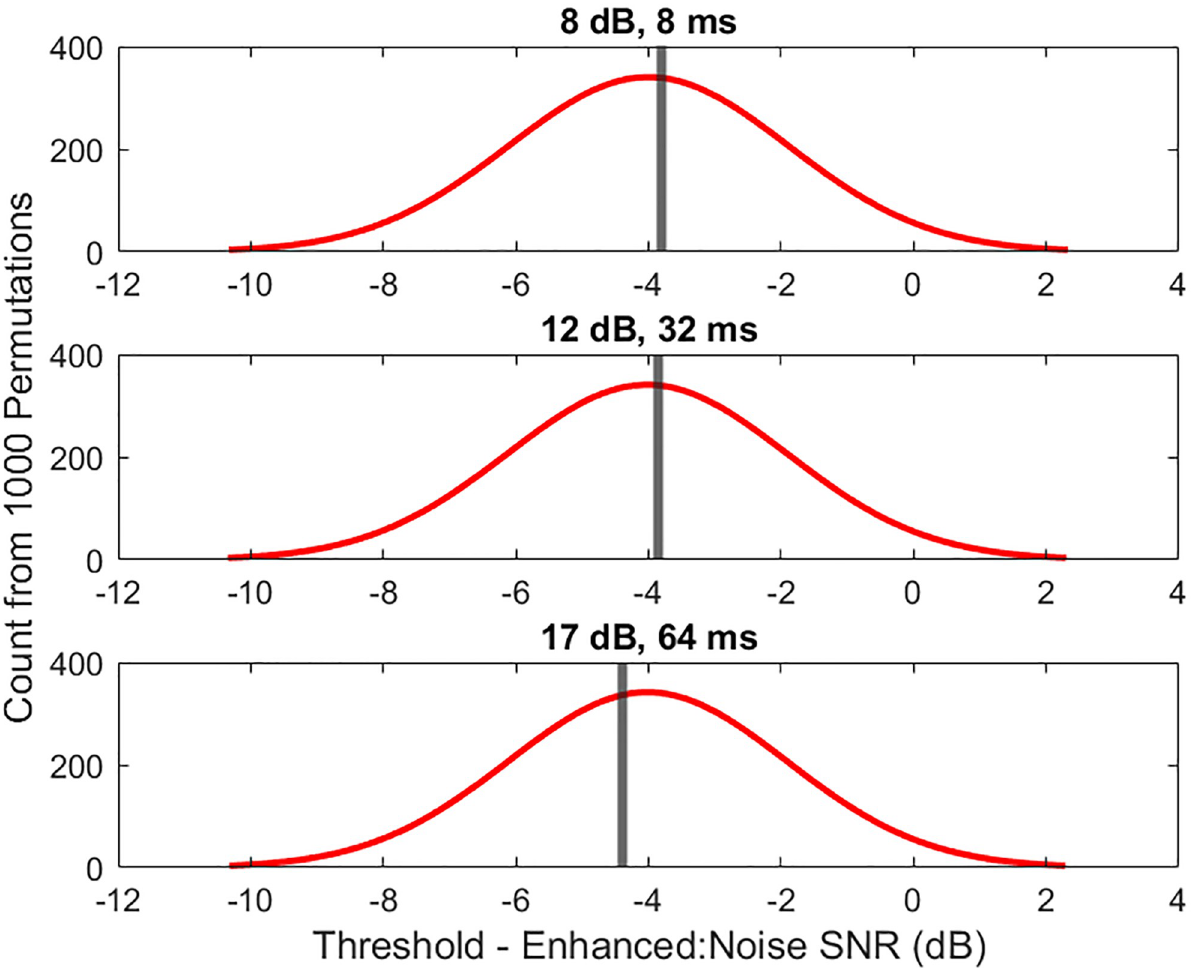
Fig 5. Visual for permutation statistics. The distribution of thresholds from the permutation statistics is shown in red. The gray line shows where the average from the experimental data falls within the distribution.